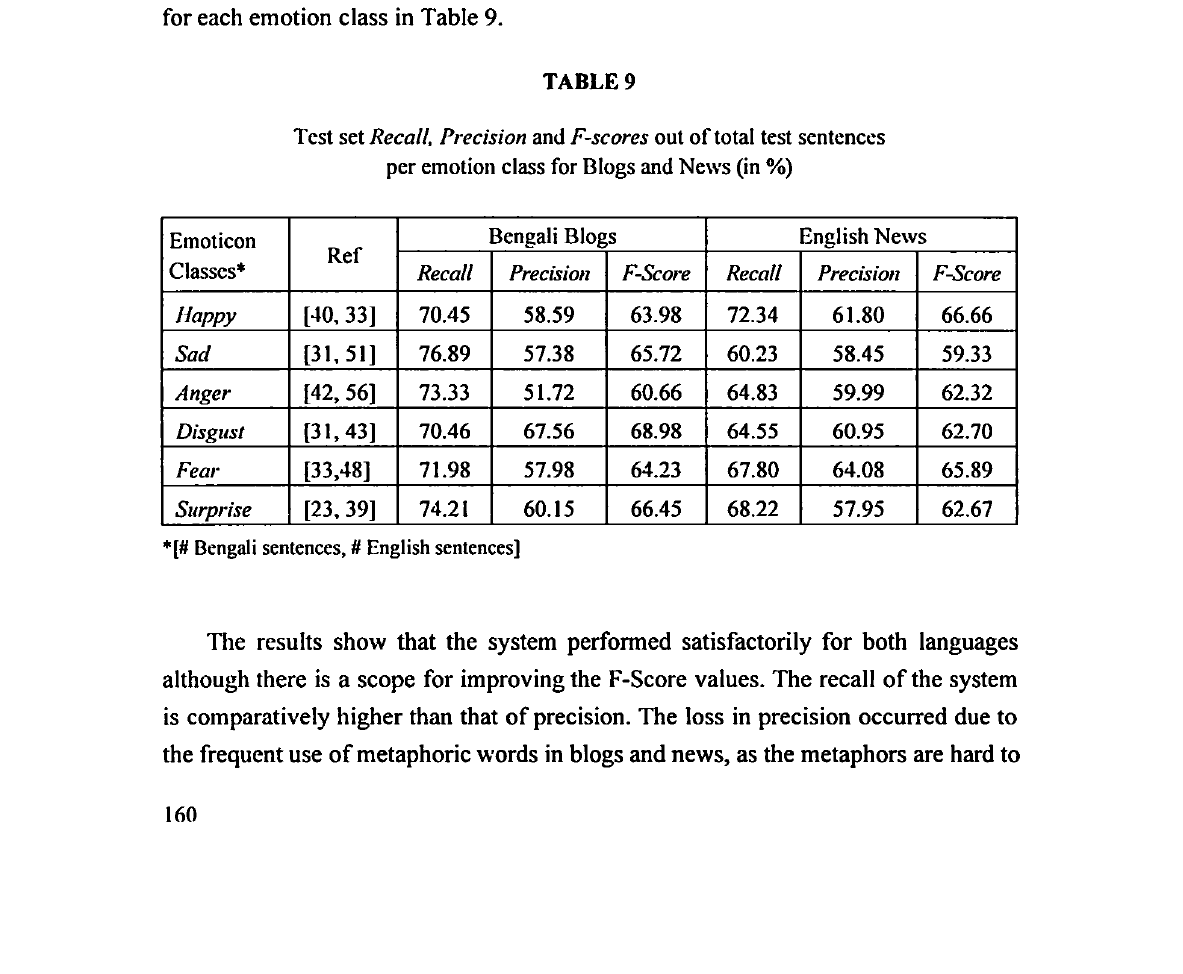
Test set Recall, Precision and F-scores out of total test sentences per emotion class for B logs and News (in